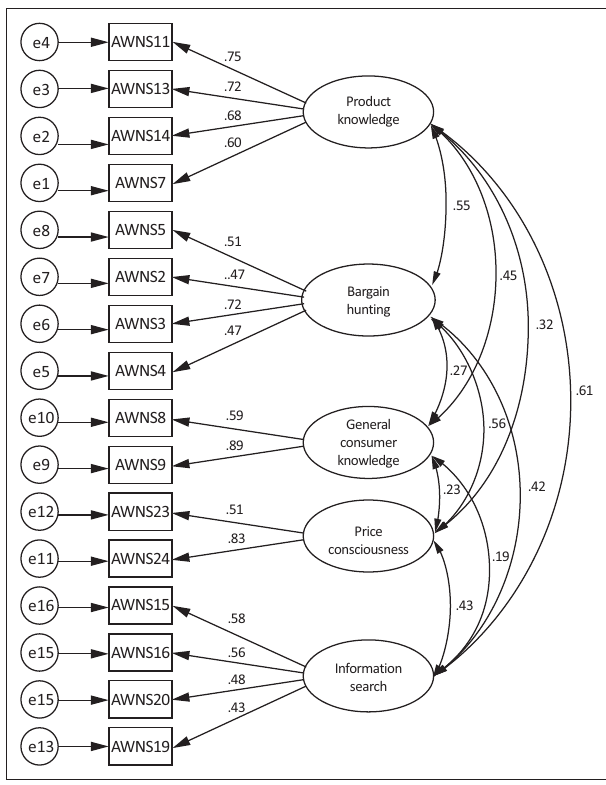
FIGURE 1: The measurement